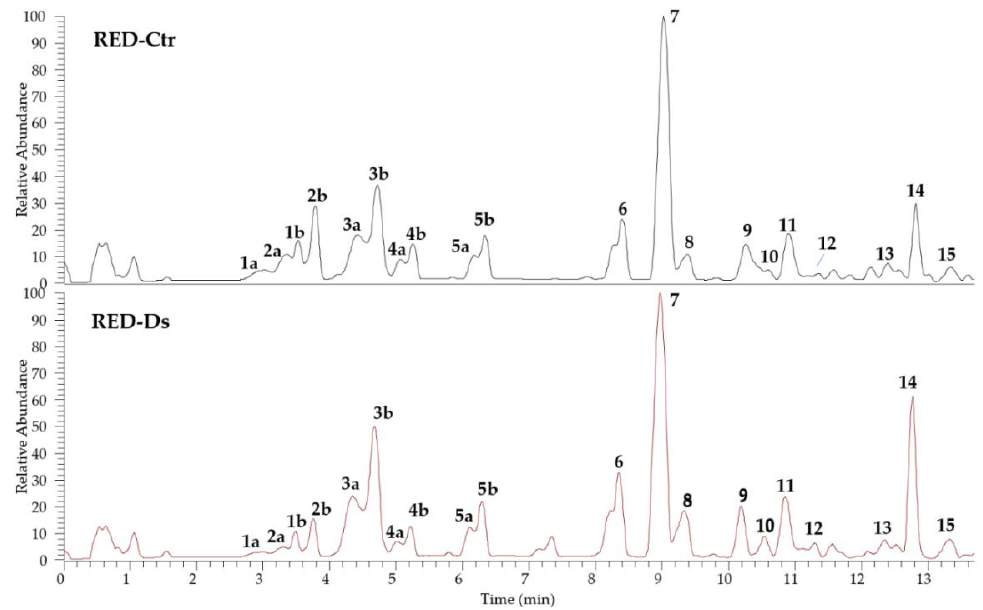
Figure 2. UHPLC-HR-ESI-MS profiles of tomato peel extracts of plants grown in normal (RED-Ctr) and in drought stress (RED-Ds) conditions. Table 1. UHPLC-HR-ESI-MS/MS data of phenols detected in peel extracts of plants grown in normal (RED-Ctr) and in drought stress (RED-Ds) conditions.